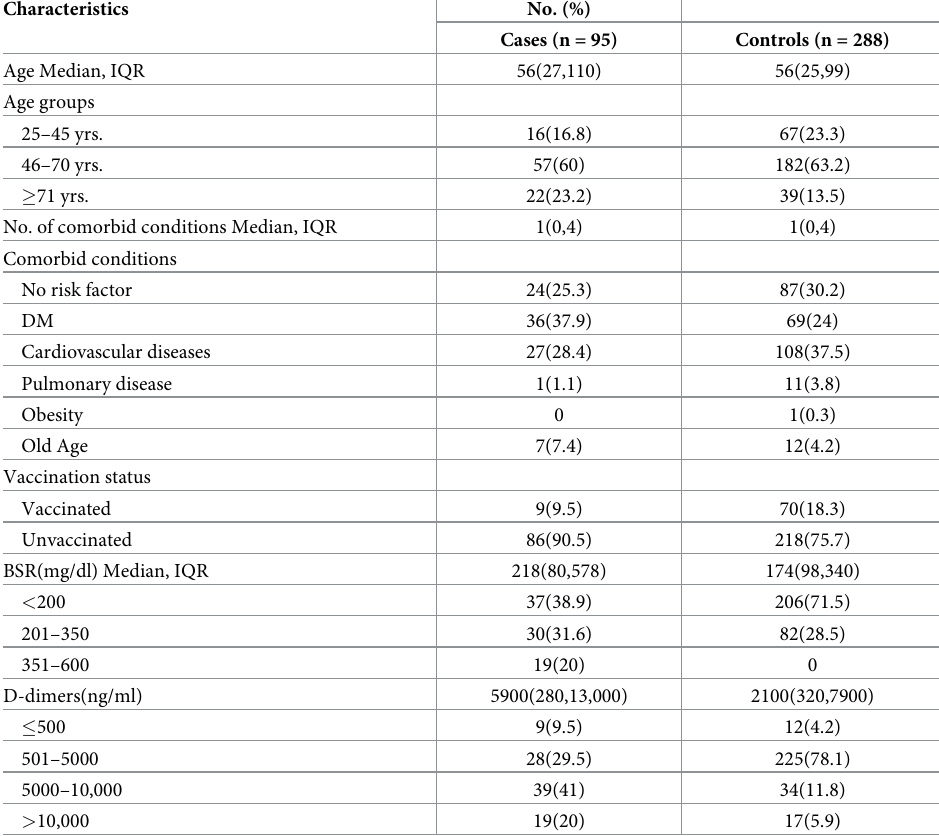
Table 1. Characteristics of case patients (with neurological complications) and control patients (without neuro- logical